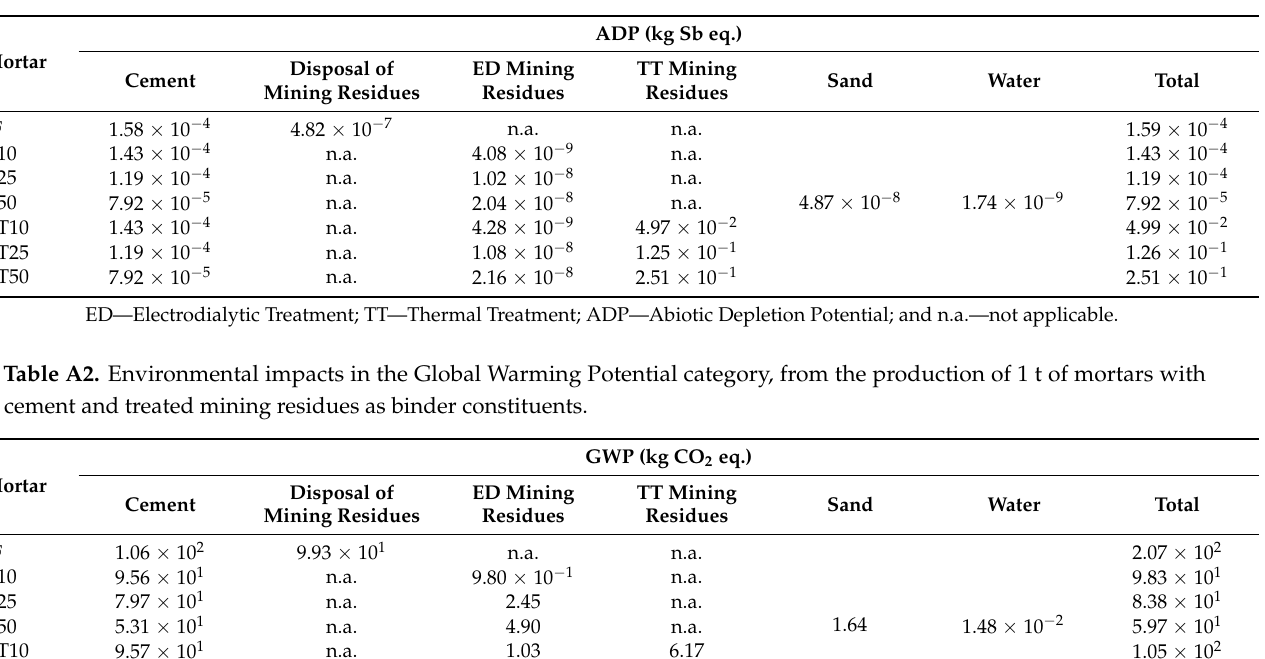
Table A1. Environmental impacts in the Abiotic Depletion Potential category, from the production of 1 t of mortars with cement and treated mining residues as binder constituents.